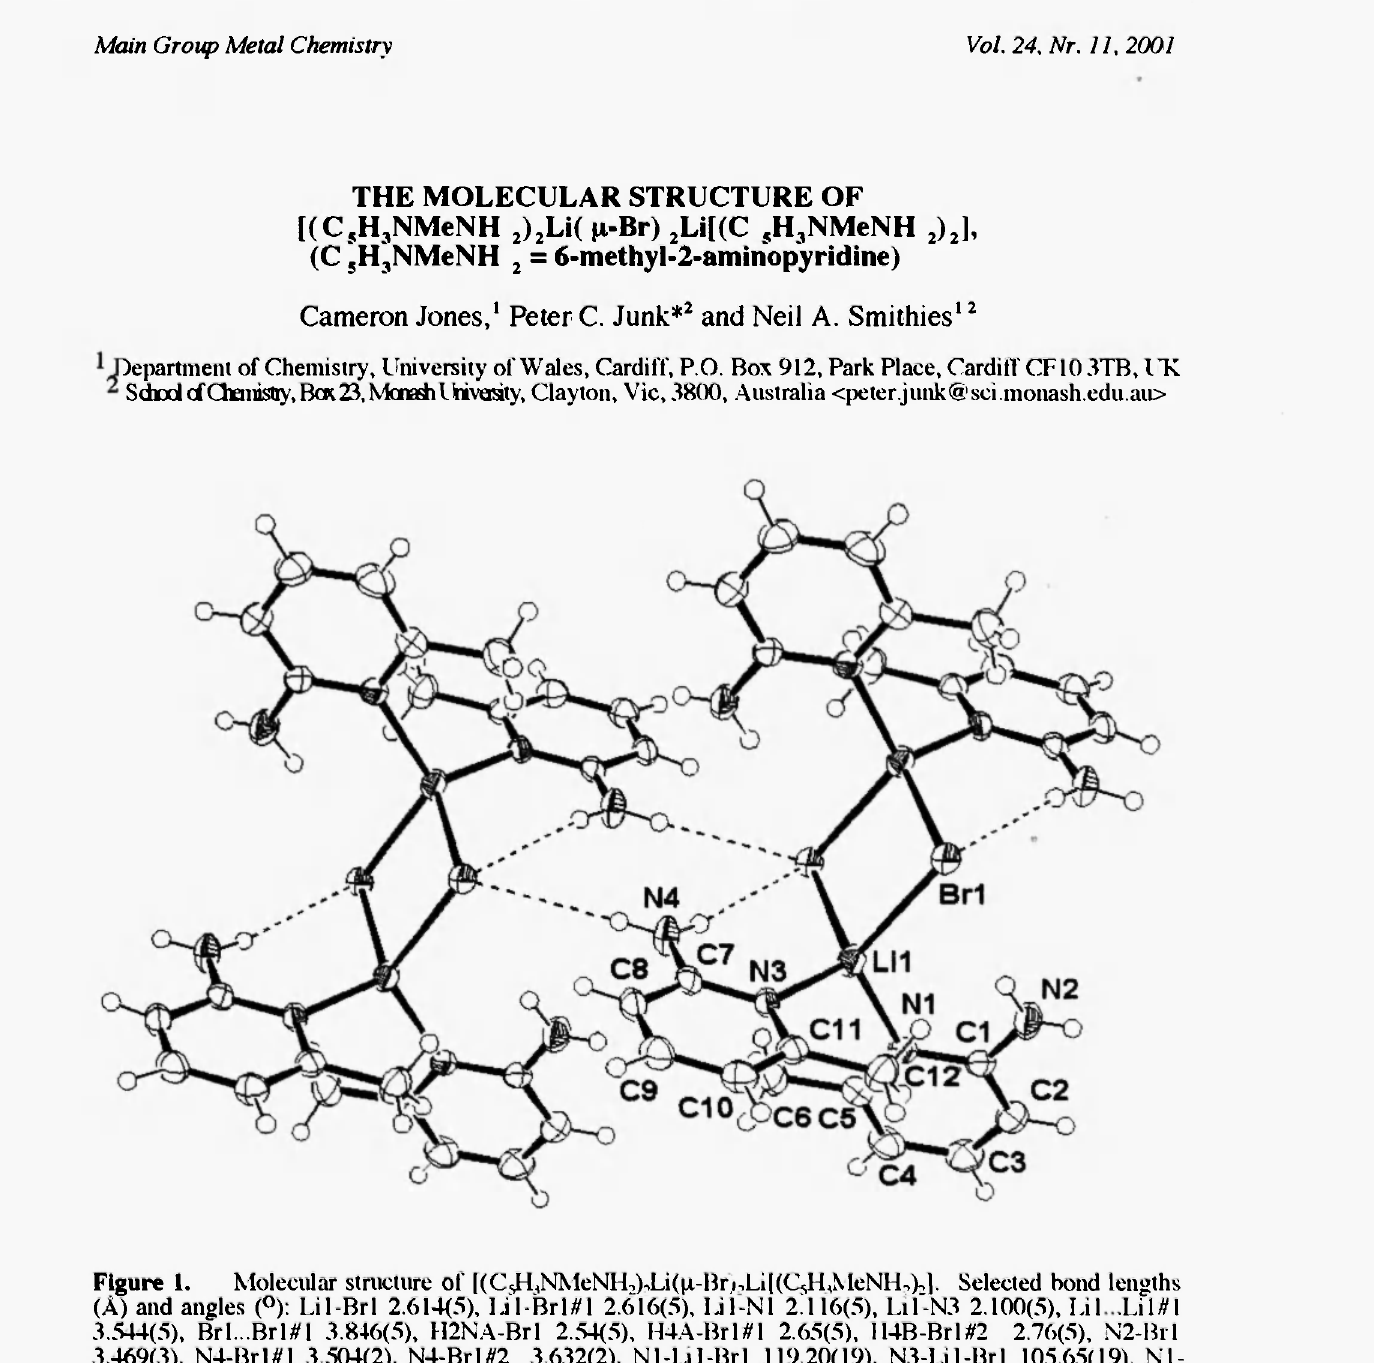
Figure 1. Molecular structure of [(Cs^NMeNH^^i^-BridJKQHMeNH,)·,!. Selected bond lengths (A) and angles (°): Lil-Brl 2.614{5), Ijl-Brl#l 2.616(5), Iji-Nl 2.116(5), Lif-N3 2.100(5), L i l . L